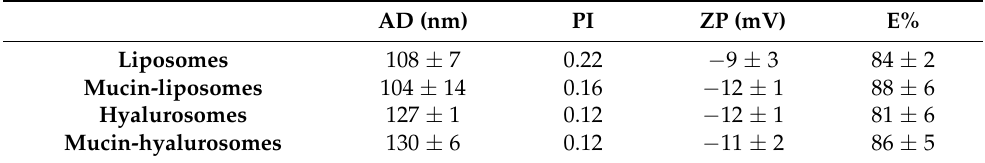
Table 2. Average diameter (AD), polydispersity index (PI), surface zeta potential (ZP) and entrapment are reported ( n =